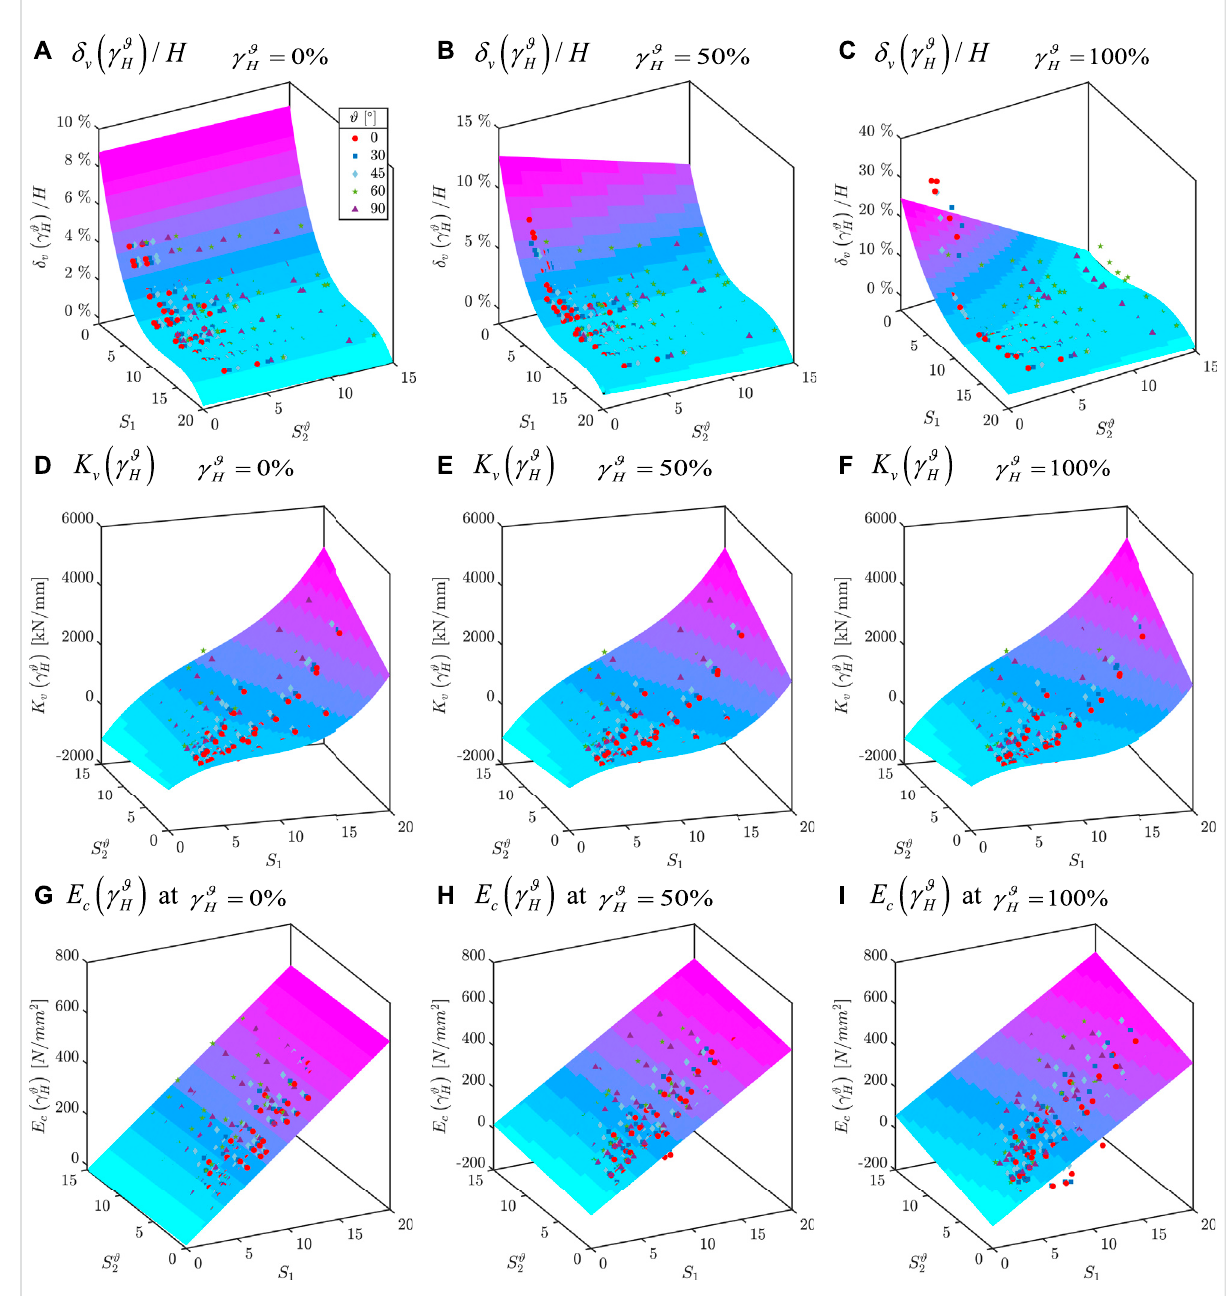
FIGURE 7 Trends of the vertical deformation, vertical stiffness and effective compressive modulus with both primary and secondary shape factors.